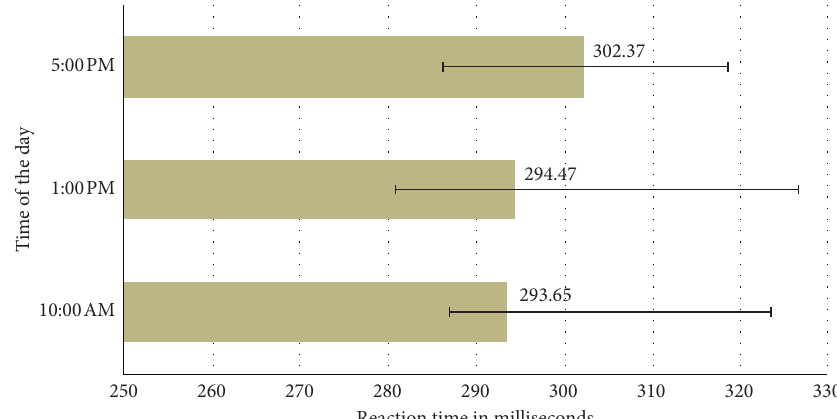
Figure 1: Visual simple reaction time of study participants at different times of the day. The data shown are the median reaction time; the horizontal error bars represent the 25th and 75th percentiles.